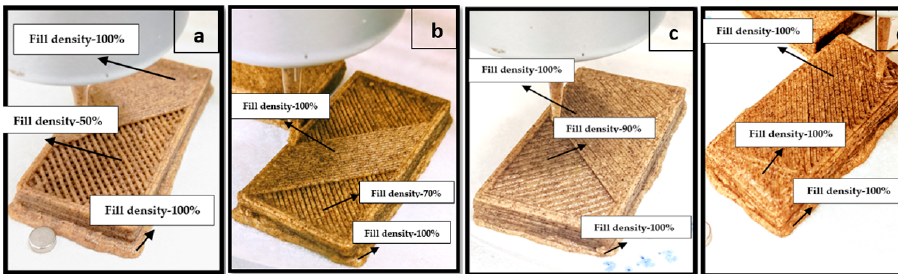
Figure 1. Representative images of 3D designs developed for cookies with different fill densities (F.D.).